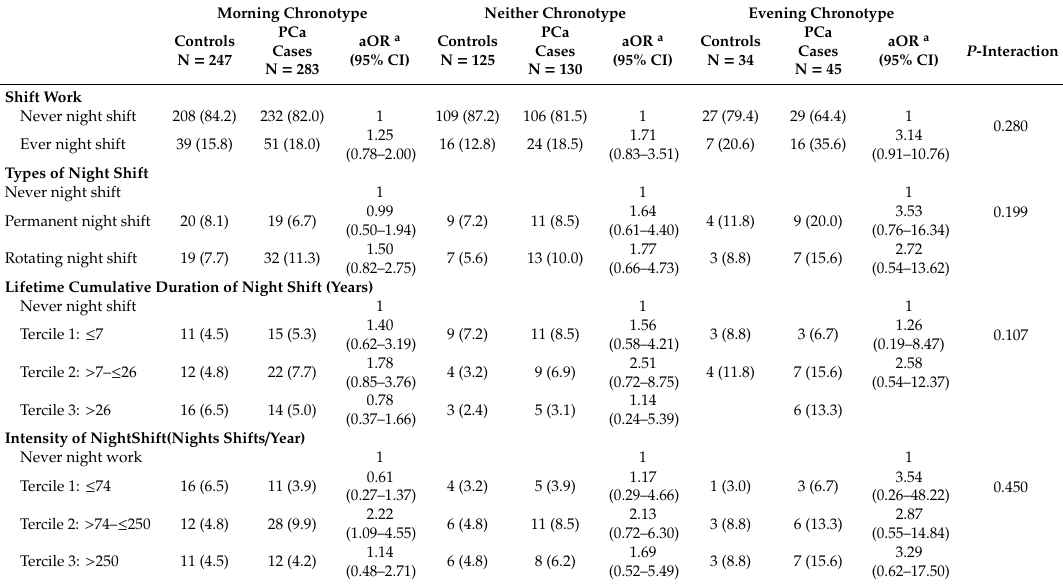
Table 4. Associations between night work indicators and PCa risk according to